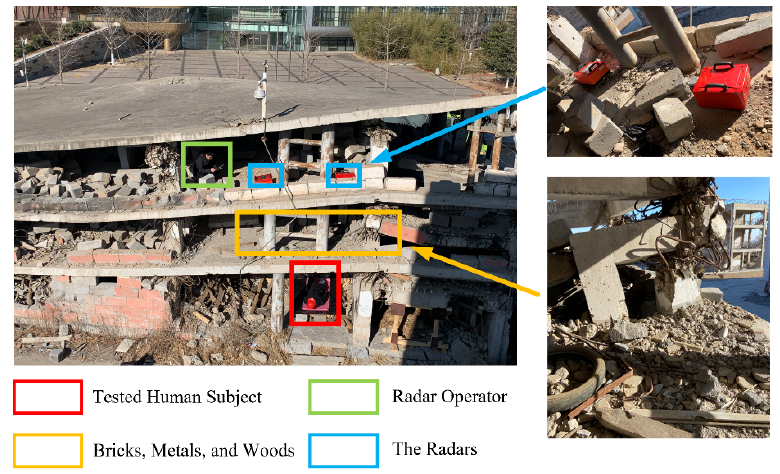
Figure 16. Ruin scene for quasi-static human being detection in scanning operating